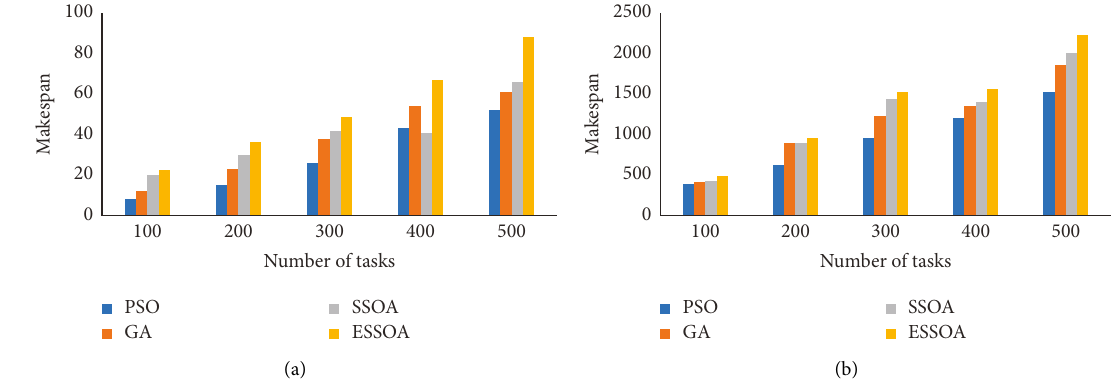
Figure 3: Makespan of the proposed and existing algorithms. (a) Makespan using Google Cluster and (b) makespan using PlanetLab.